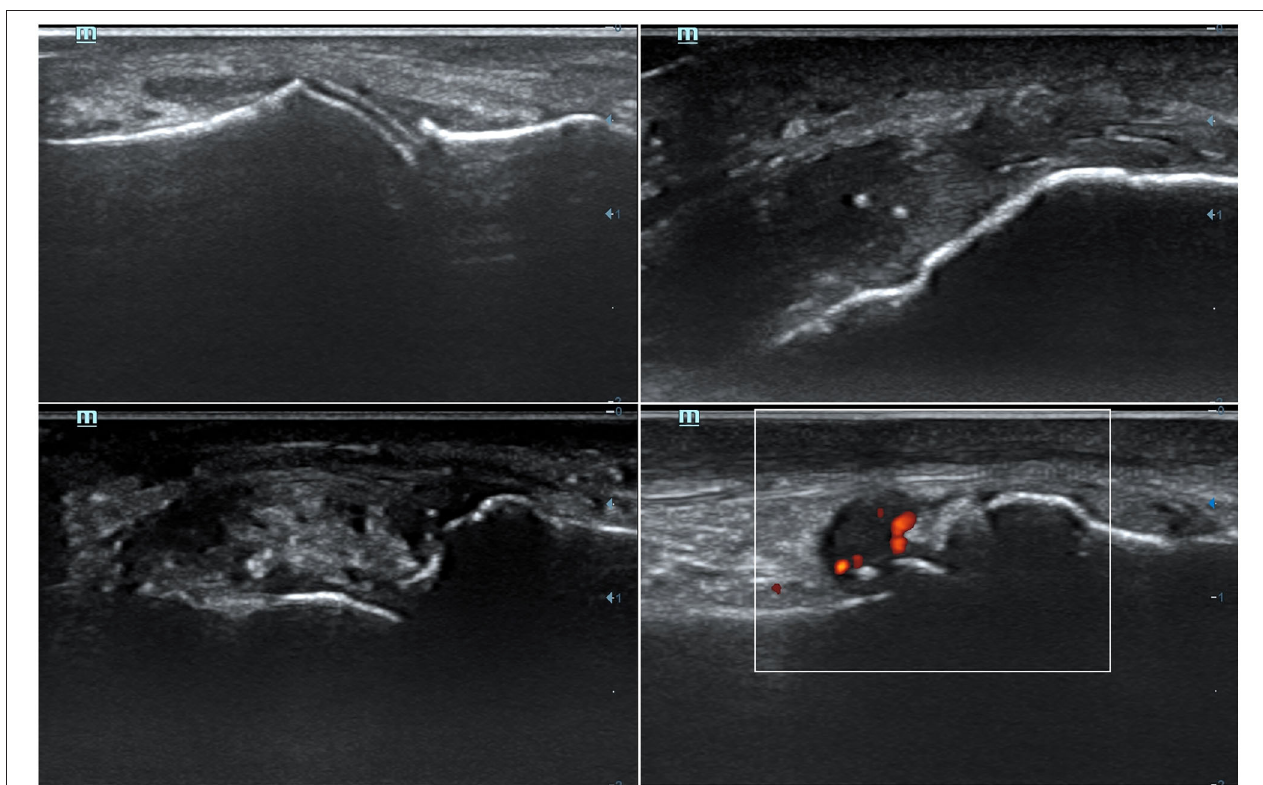
FIGURE 1 | Representative ultrasound features of monosodium urate crystal deposits and associated inflammation. (Up-left) A double contour sign at the cartilage of the 1st metatarsal bone. (Up-right) Two aggregates inside distal patellar tendon. (Bottom-left) A tophus seen at the radial aspect of the 2nd metacarpophalangeal joint. (Bottom-right) A positive (grade 2) power-Doppler signal at 1st metatarsophalangeal joint, indicative of